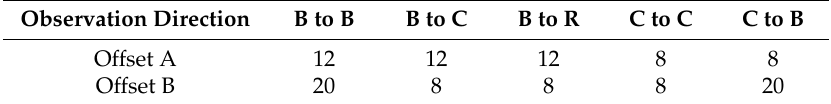
Table 1. Observing offset in the visibility analysis. B: Beacon tower; C: City site; R: General relic. Observation Direction